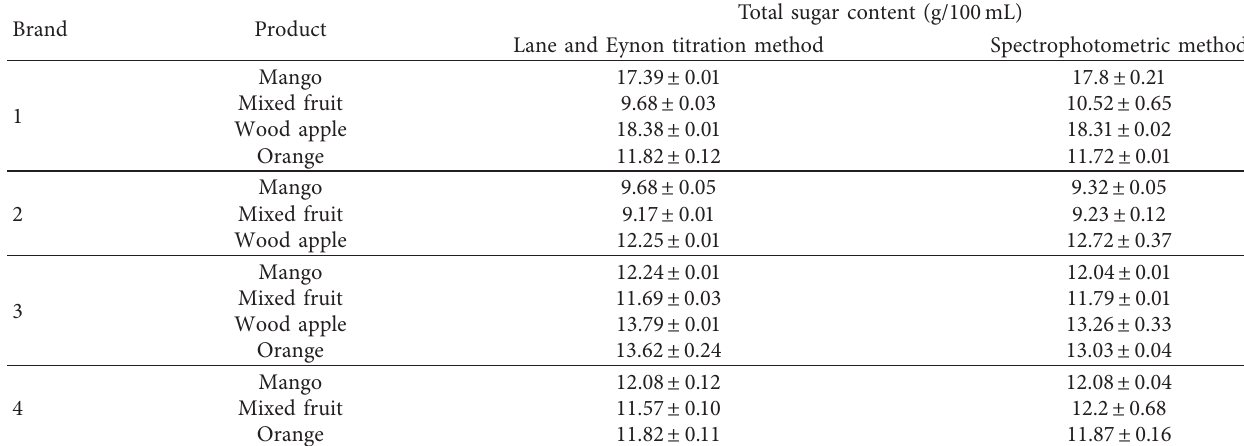
Table 1: Total sugar content in fruit nectars (Lane and Eynon titration method and spectrophotometric method). Brand